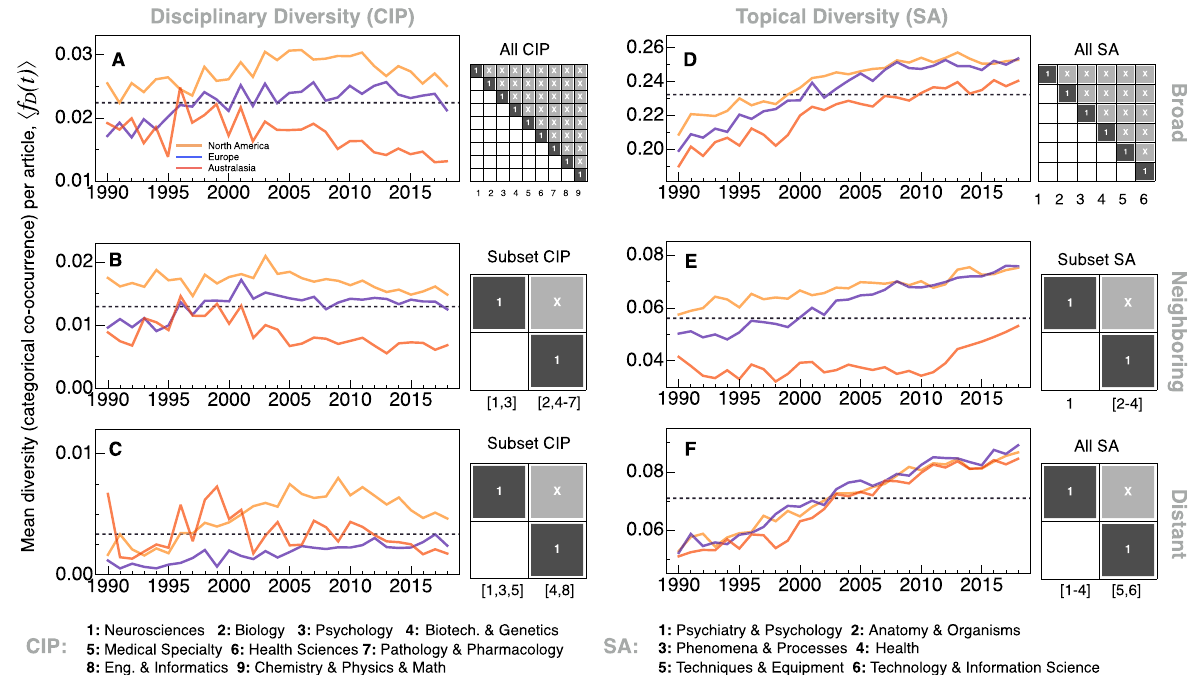
Fig. 4 Evolution of CIP and SA diversity in Human Brain Science research. A – F Each 〈 f D ( t ) 〉 represents the average article diversity measured as categorical co-occurrence, by geographic region: North America (orange), Europe (blue), and Australasia (red). Each matrix motif indicates the set of CIP or SA categories used to compute D p in Eq. (1); categories included in brackets are considered in the union. For example, panel ( A ) calculates 〈 f D ,CIP ( t ) 〉 across all 9 CIP categories; instead, panel ( B ) is based upon counts for two super-groups, the fi rst consisting of the union of CIP counts for categories 1 and 3, and the second comprised of categories 2, 4, 5, 6 and 7. A , D Broad diversity is calculated using all categories considered as separate domains; ( B , E ) Neighboring represents the shorter-distance boundary across the neuro-psychological ↔ bio-medical interface; ( C , F ) Distant represents longer-distance convergence across the neuro-psycho-medical ↔ techno-informatic